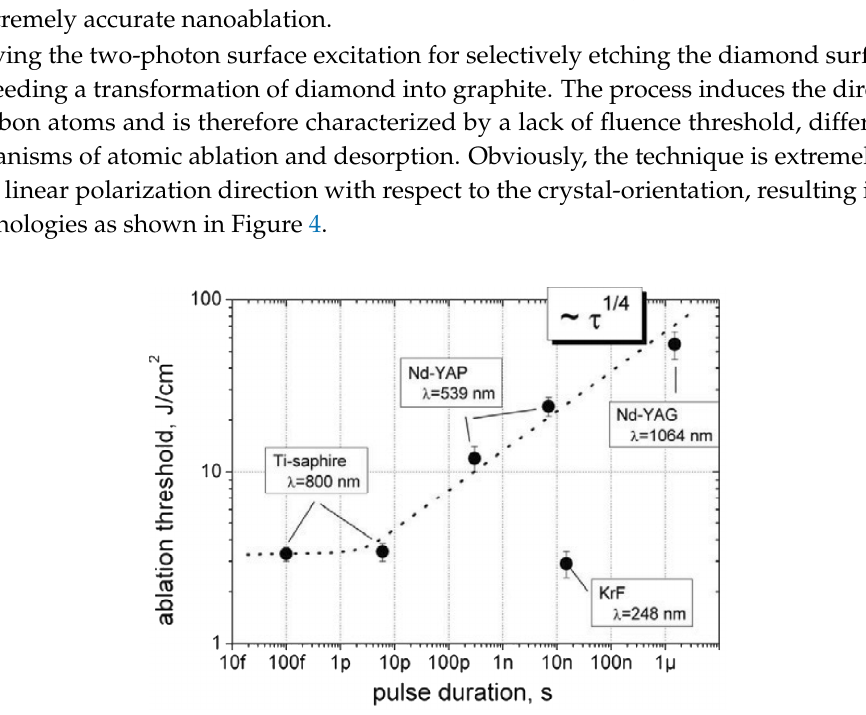
Figure 3. Dependence of the chemical vapor deposition (CVD) diamond ablation threshold on the laser pulse duration [51]. (Copyright 2011 Elsevier).